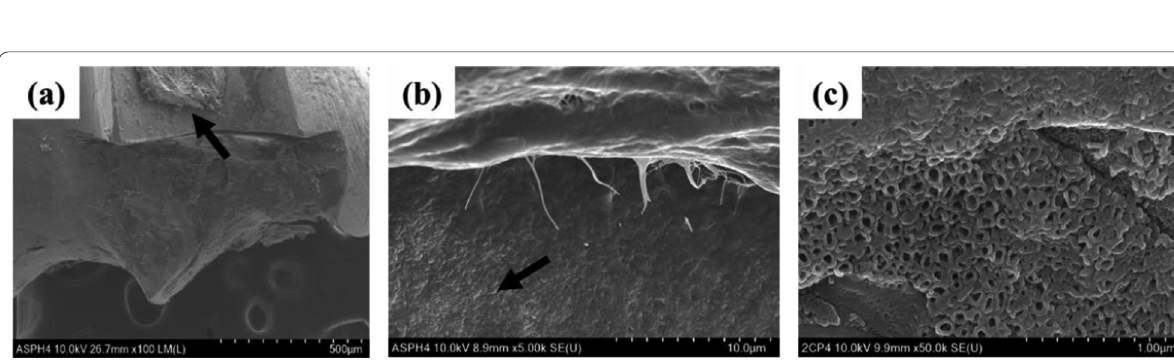
magnification, b ×